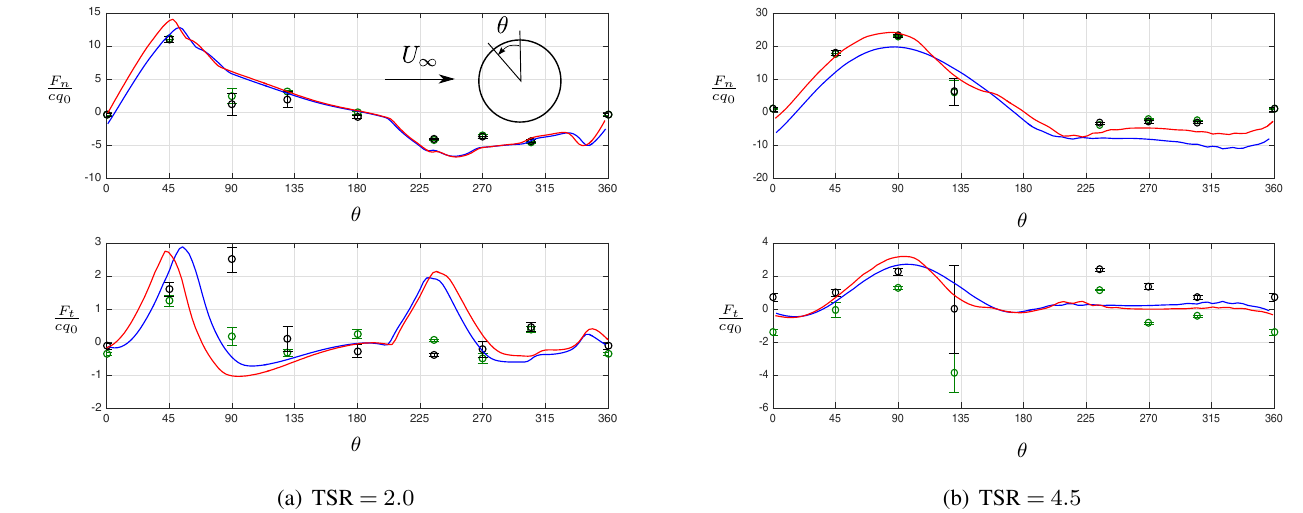
Figure 1. Validation: evolution of the normal, F n / ( cq 0 ), and tangential, F t / ( cq 0 ), force coefficients at mid-height vs. the blade angular position θ ; VPM simulation without curvature correction (blue solid line) and with curvature correction (red solid line); experimental results ( o ) with two techniques of force computation from particle image velocimetry (PIV) flow fields (Castelein, 2015).